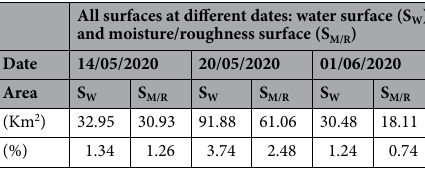
Table 6. Results obtained from water surfaces and moisture/roughness at different